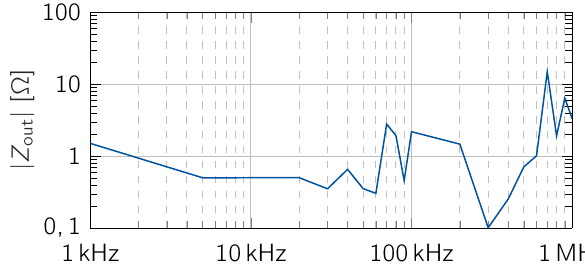
Figure 11: Measured output impedance of the balanced VS with C v = 82 pF.